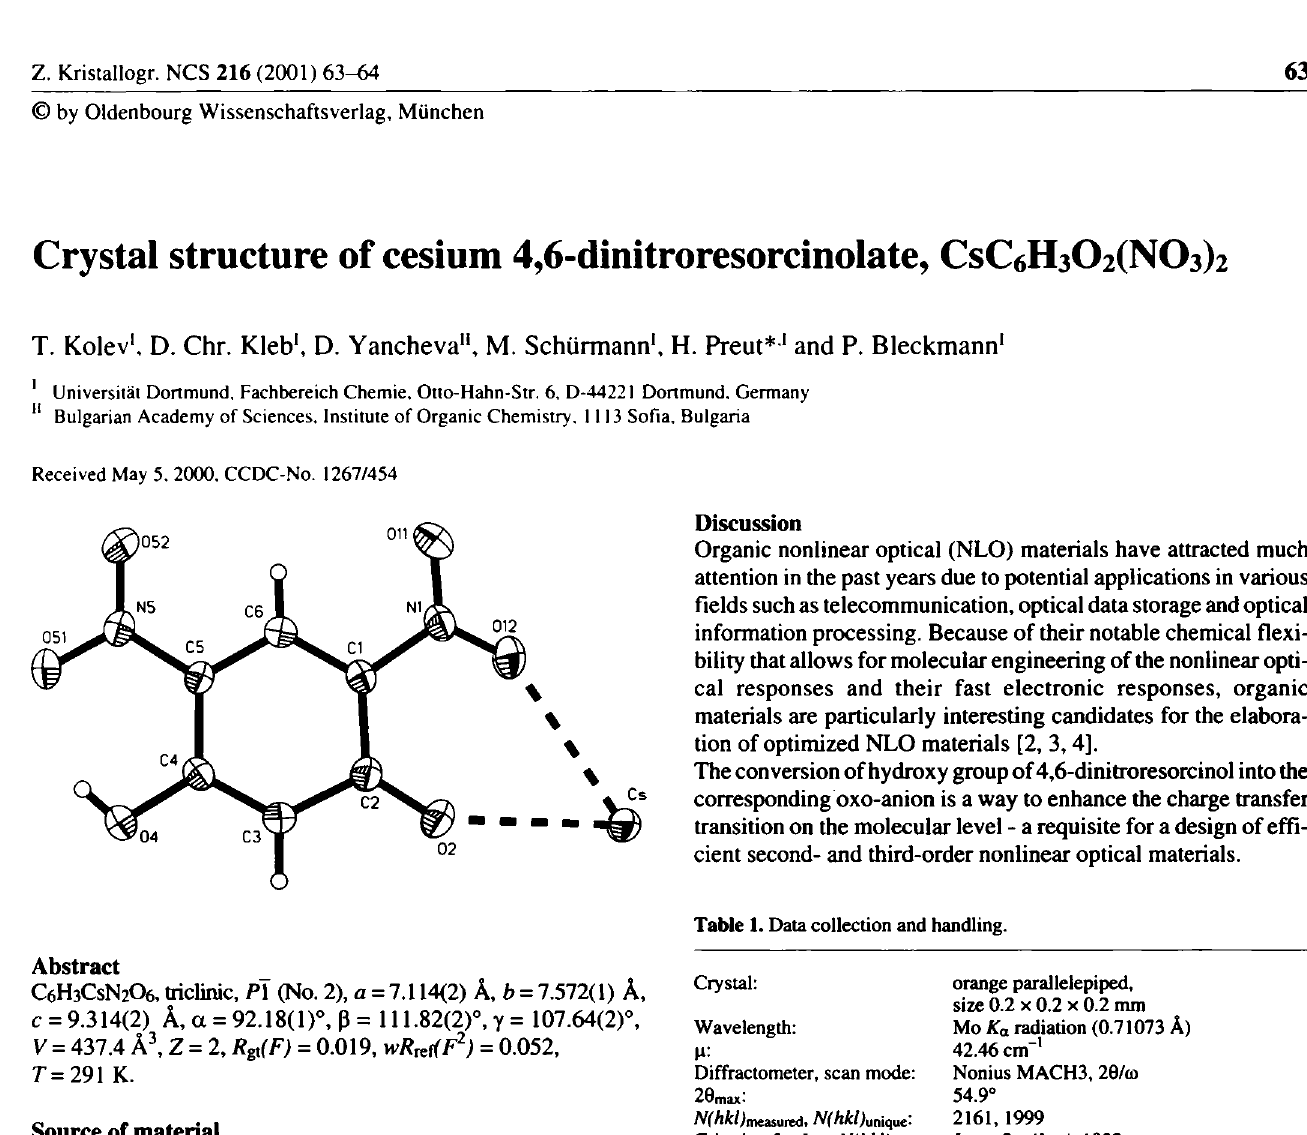
Table 2. Atomic coordinates and displacement parameters (in A 2